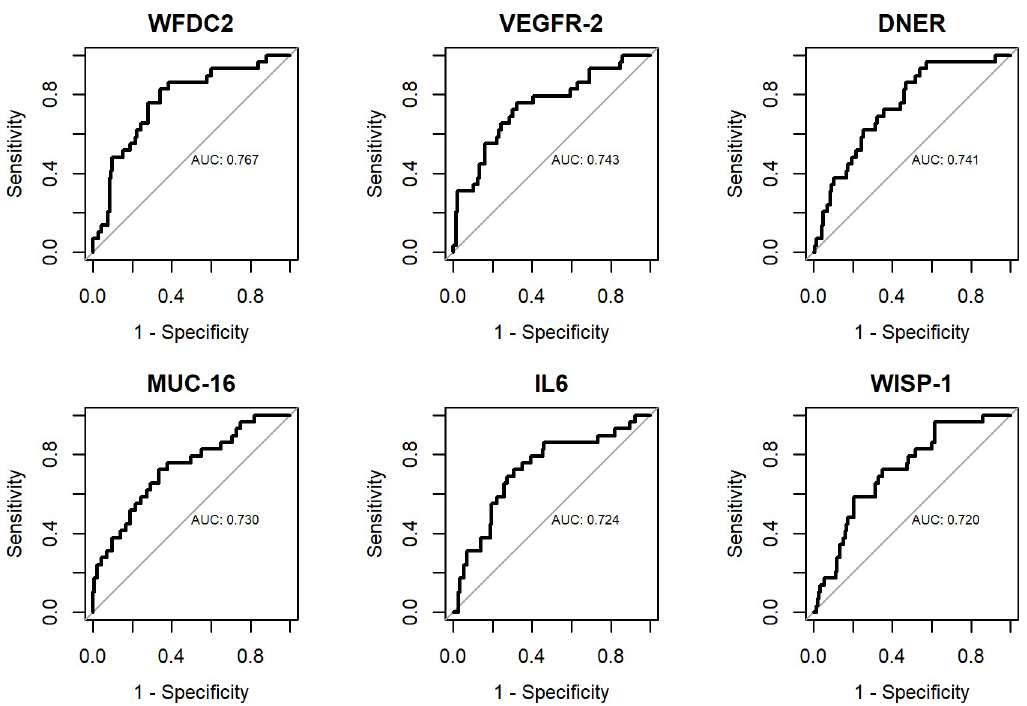
Fig 3. ROC curves for individual biomarkers. Benign tumors vs. borderline + cancer.